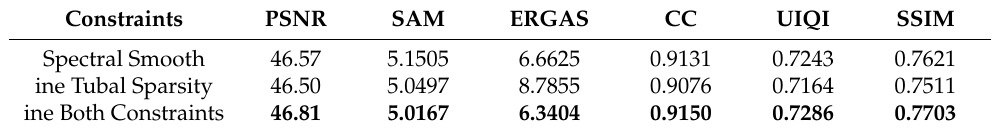
Table 3. The necessity of using spectral smooth and tubal row-sparse